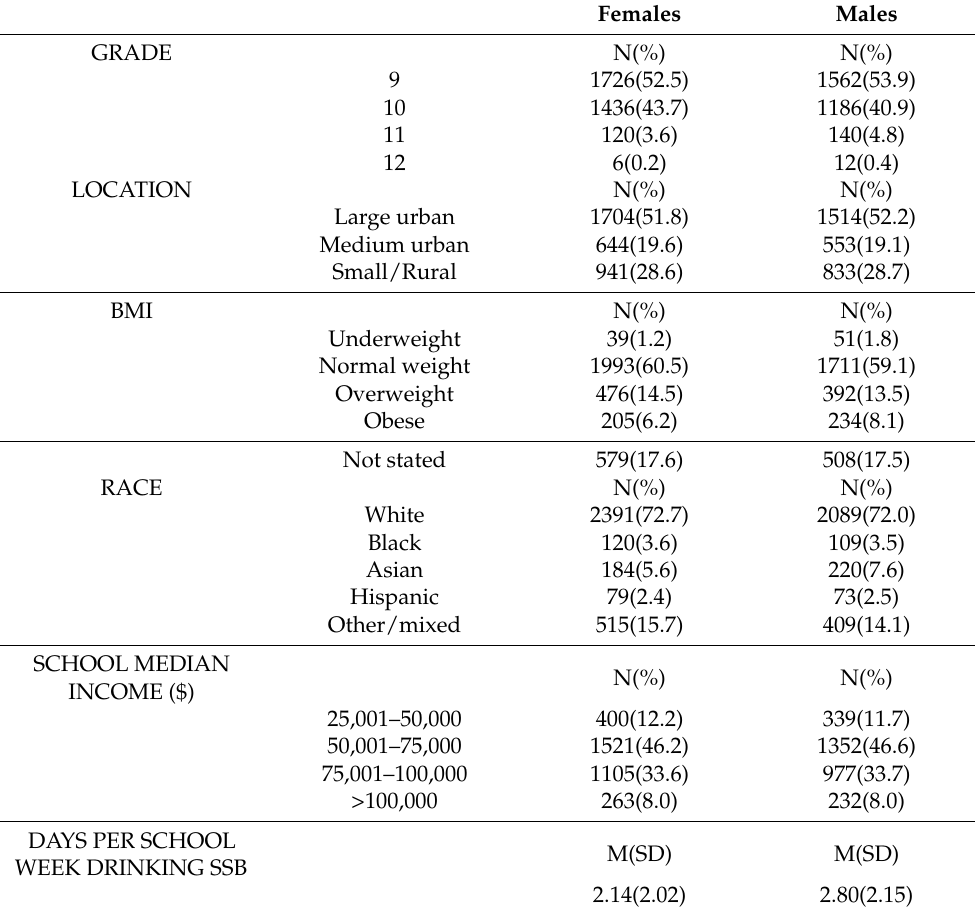
Table 4. Demographic and descriptive statistics of participants at Time 1 (2016/17) for current smoking and vaping status in the COMPASS study at Time 2